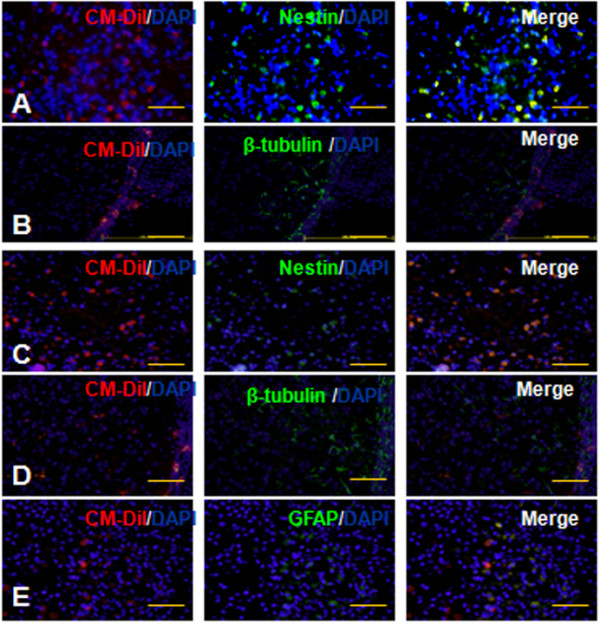
Transplanted cells survived and migrated into the stroke-damaged host tissue (bar = 100 μm). The NSCs derived from iPSCs differentiated into neural cells, which were immunopositive for Nestin(A, C) and β-tubulin (B, D) (A, B: group of transplantation for 7 days; C, D: group of transplantation for 14 days). Two weeks after transplantation, some of the transplanted cells were immunopositive with GFAP (E).